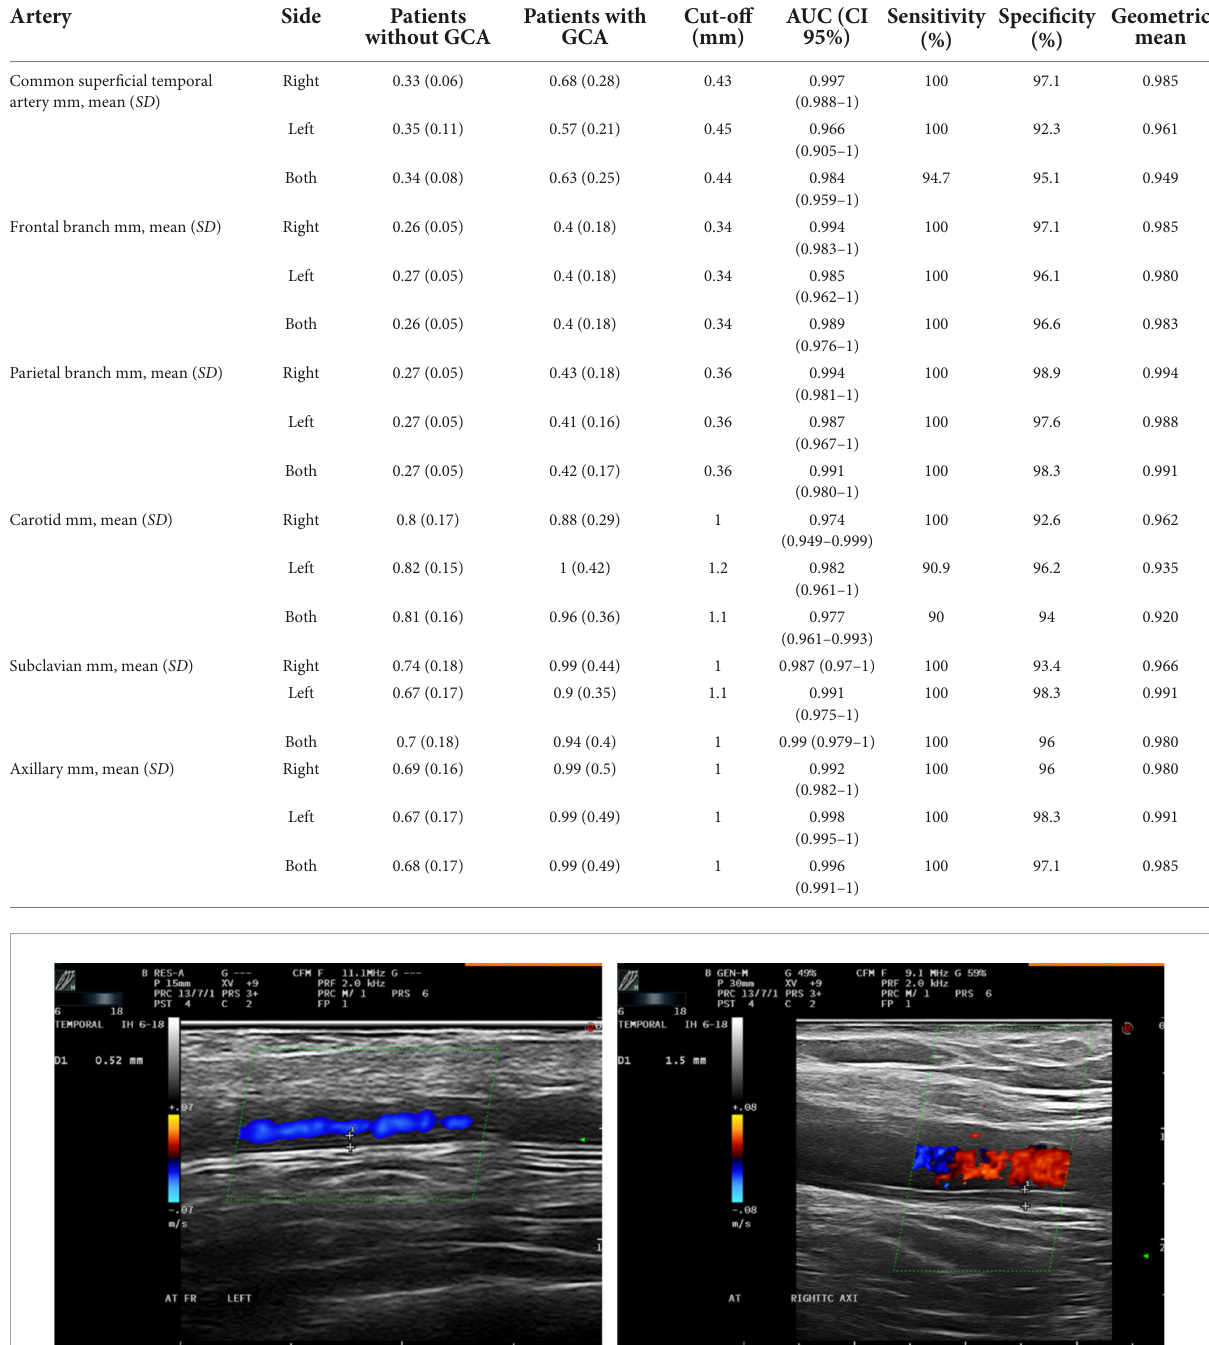
TABLE 2 Optimal IMT cut-off values for cranial and extracranial arteries. Artery Side Patients